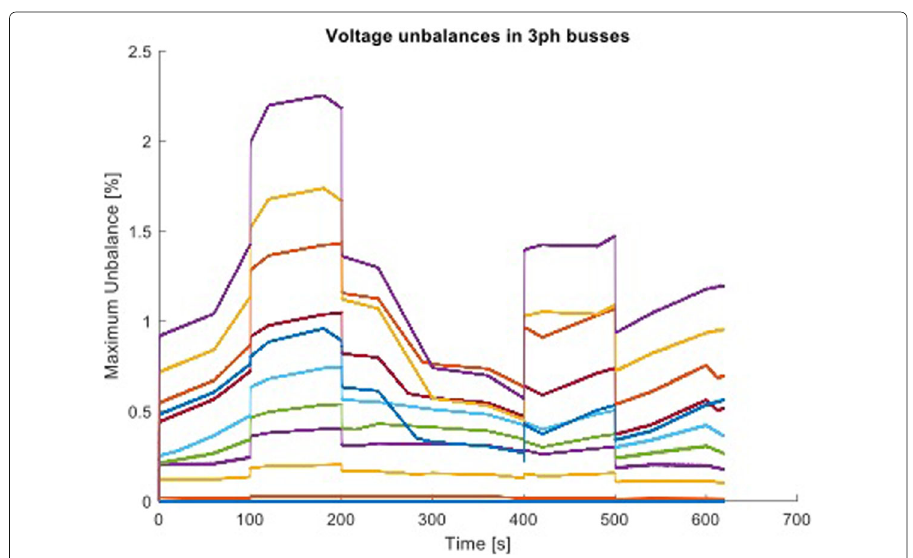
Fig. 3 Voltage Readings from 9-Bus V2G System